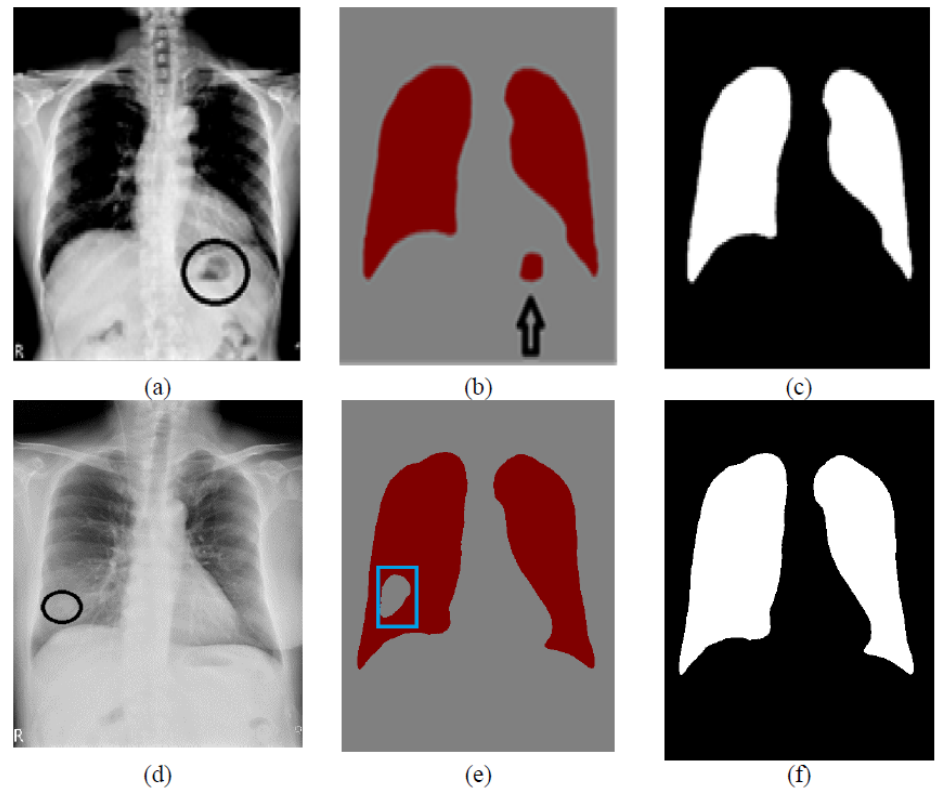
Figure 8. Examples of post-processing: ( a , d ) are the original images; ( b ) is the case of a dark spot outside the lungs which is classified as the lung; ( e ) is the case of a white spot in the lung field, which is classified as the background; ( c , f ) are the post-processed results. Algorithm 1 . Lung Field Segmentation